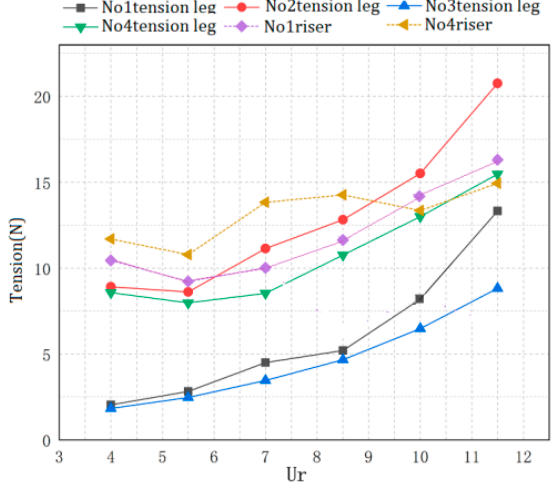
Figure 8. Variation of tension amplitude of tension leg and riser with the reduced speed.